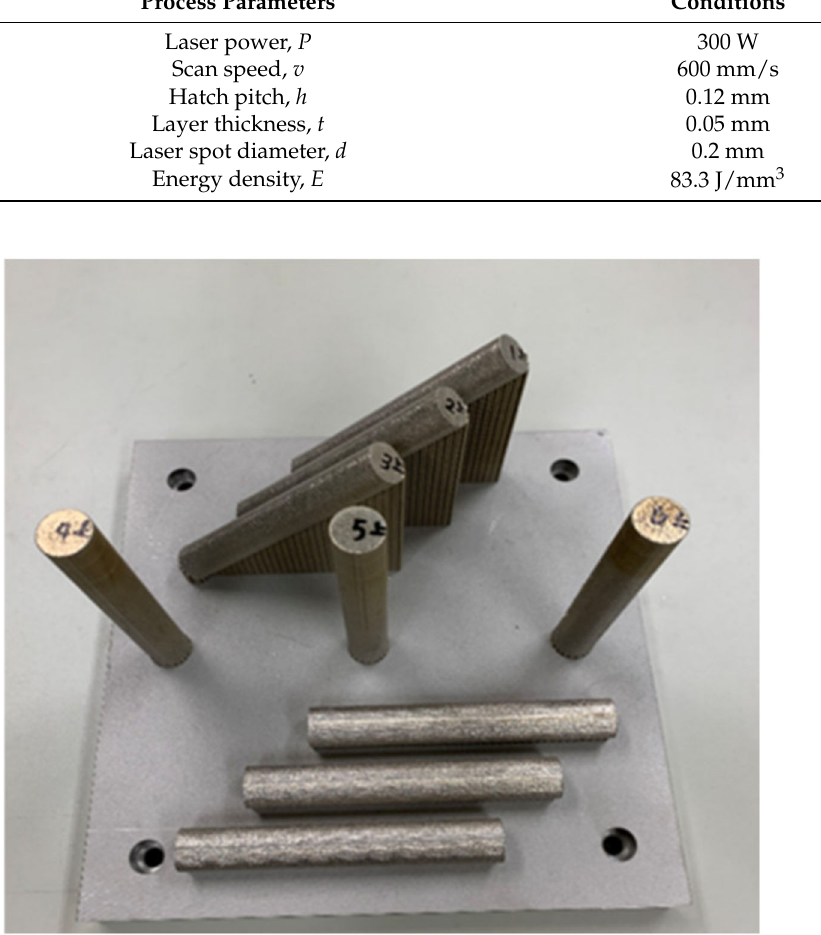
Figure 11. Round bars for tensile test specimens in the direction of 0 ◦ , 45 ◦ , and 90 ◦ to the horizontal plane of the base